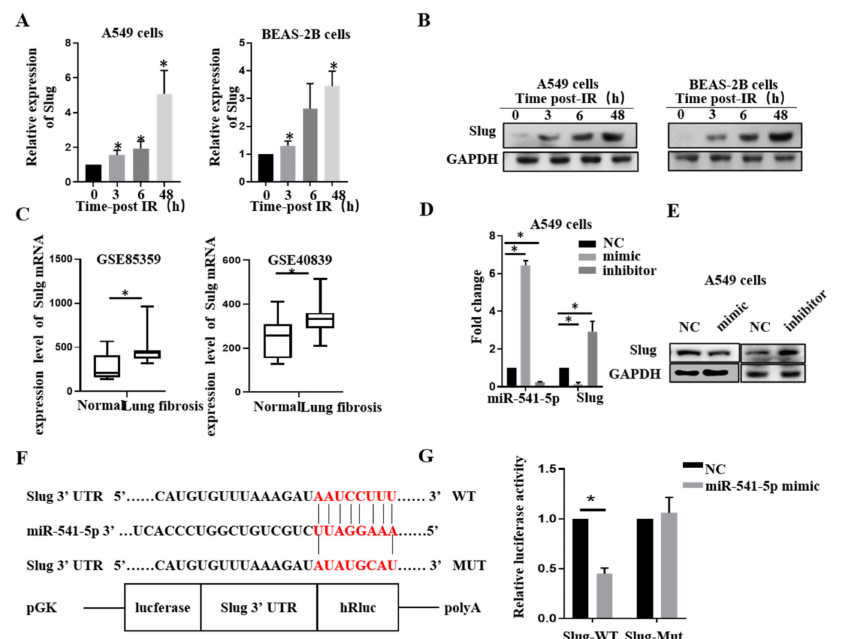
Figure 3. Slug was revealed as a direct target of miR-541-5p. A549 cells (left) and Beas 2B cells (right) were irradiated with 6 Gy of radiation. Detection of ( A ) Slug mRNA and ( B ) Slug protein using RT-qPCR or Western blotting at 0, 3, 6, and 48 h. ( C ) Comparison of Slug mRNA in lung tissues between a normal population and lung fibrosis patients (GSE40839) or mice (GSE85359) from NCBI (https://www.ncbi.nlm.nih.gov/ accessed on 18 October 2021) ( D ) Transfection of the miR-541-5p mimic and inhibitor in A549 cells and determination of the expression level of Slug mRNA using RT-qPCR. ( E ) Detection of the protein expression of Slug using Western blot analysis. ( F ) Information regarding the 3 (cid:48) -UTR binding site for the binding between miR-541-5p and Slug. ( G ) Slug 3 (cid:48) -UTR WT (wild-type)/MUT (mutant) and the miR-541-5p mimic cotransfected in HEK-293T cells, followed by the detection of luminescence based on a dual-luciferase reporter system. * p < 0.05 versus the